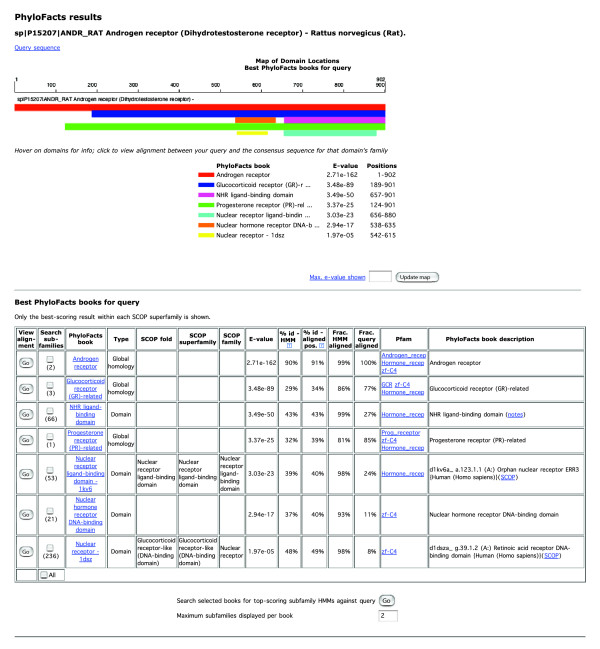
PhyloFacts search results for ANDR_RAT, androgen receptor from Rattus norvegicus. Books with significant scores are displayed graphically at top, followed by various statistics about each match in a table below. The top-scoring book (red bar) represents a global homology group of Androgen receptors, which matches the entire query sequence. Examining the table below shows the Androgen receptor book has an E-value of 2.71e-162, 91% identity between the query and book consensus (based on aligned residues), and high fractional coverage of the HMM (99%). Other global homology groups retrieved include evolutionarily related Glucocorticoid and Progesterone receptors, but analysis of query coverage and percent identity shows the Androgen receptor book to provide a superior basis for annotation transfer. Other books displayed include structural domains detected in the query. Two books (for the ligand-binding domain 1kv6a and the DNA-binding domain 1dsza) were constructed for the Structure Prediction series based on SCOP domains. Subsequent construction of the specialized book series on transmembrane receptors in the human genome resulted in additional books being constructed for these domains. Scoring subfamily HMMs is enabled by selecting the 'Search subfamilies' box (second column in the spreadsheet of results, shown checked in the figure), and clicking on the 'Go' button at bottom ('Search selected books for top-scoring subfamily HMMs against query'). Clicking on the 'Go' button below 'View alignment' in the first column brings up a separate page displaying the pairwise alignment of the query and the family consensus sequence along with relevant statistics about the alignment. Clicking on the hyperlink to the book itself (in the 'PhyloFacts book' column) retrieves the webpage for the family (see example book page shown in Figure 1).